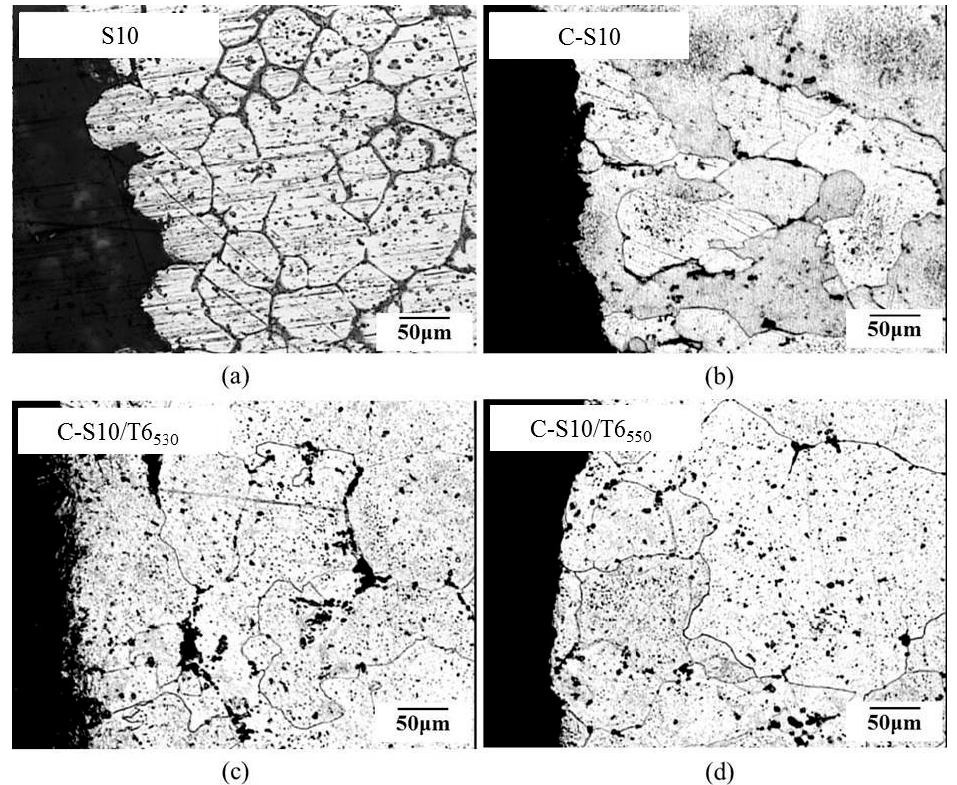
Figure 15. Sub ‐ surfaces of ( a ) S10; ( b ) C ‐ S10; ( c ) C ‐ S10/T6 530 ; and ( d ) C ‐ S10/T6 550 . Figure 15. Sub-surfaces of ( a ) S10; ( b ) C-S10; ( c ) C-S10/T6